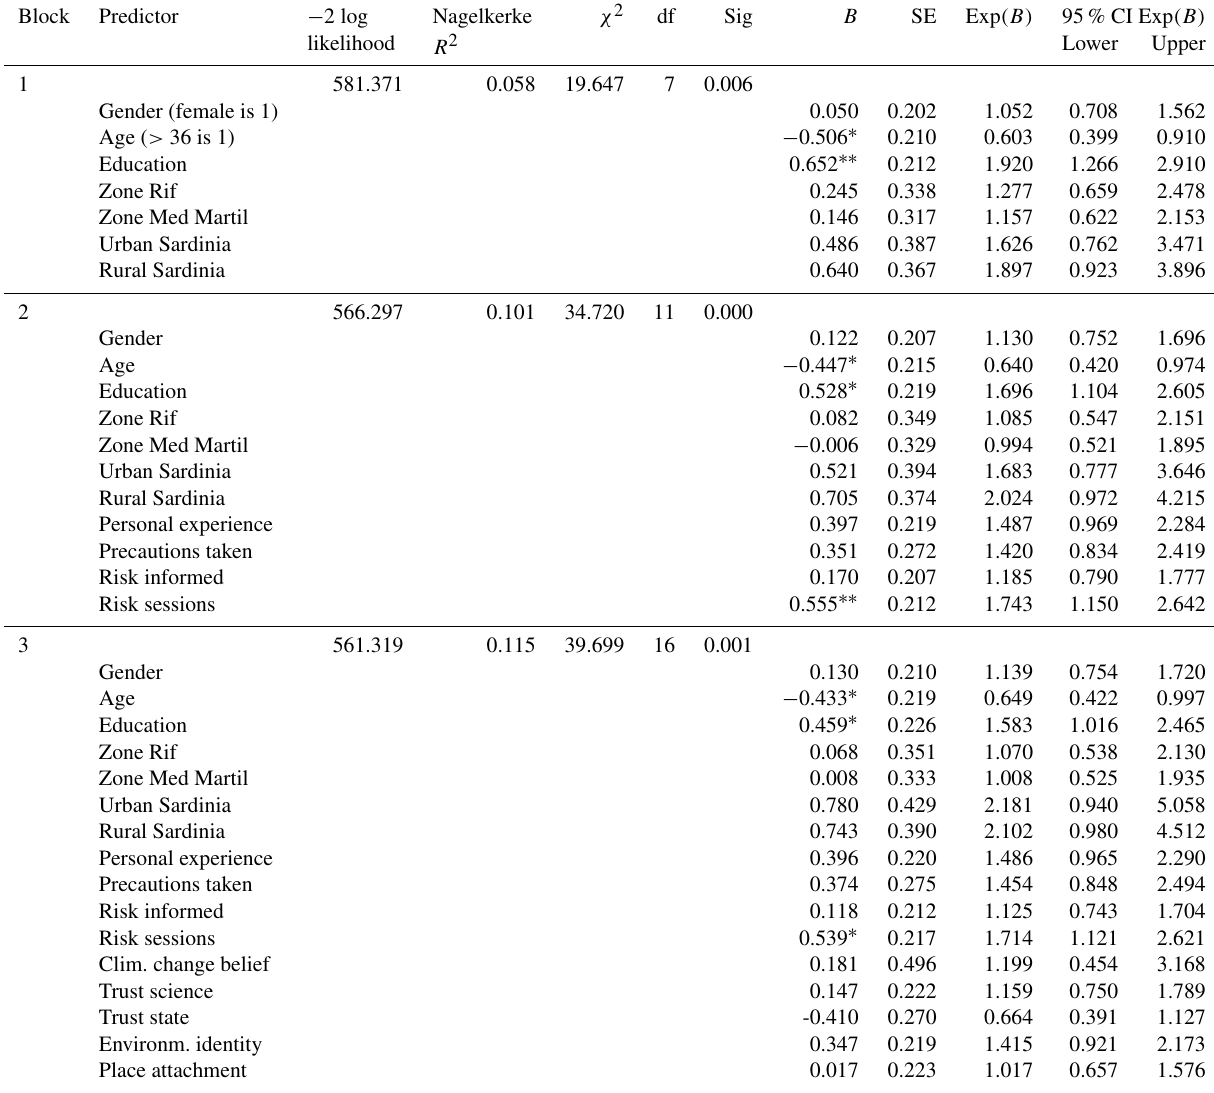
Table 3. Binary logistic model of future precautionary behaviour (“invest money”, N = 447).